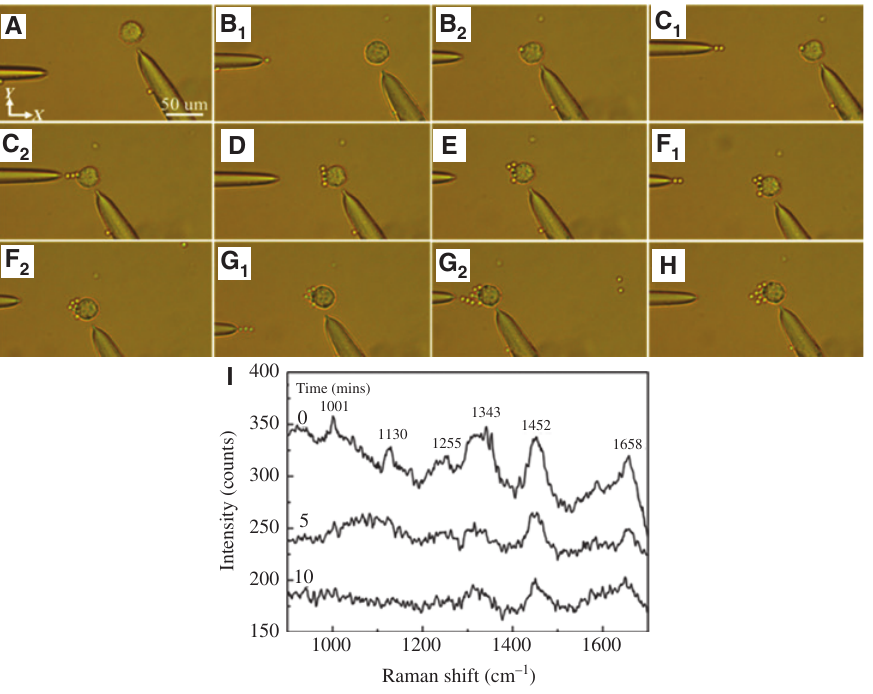
Figure 5: Optical microscope images of delivering 10 MMDs to a single K562 cell and the Raman spectrum of the targeted cell over time. (A) A single K562 cell was trapped by the right TFP and the left TFP was ready for the trapping and delivery of MMDs. (B of the first MMD. (C and C ) The delivery of the second and third MMDs at one time. (D) The fourth MMD was delivered to the targeted cell. 1 2 (E) The fifth MMD was delivered to the targeted cell. (F and F ) The delivery of the sixth and seventh MMDs at one time. (G 1 2 delivery of the eighth, ninth and tenth MMDs at one time. (H) The completed delivery of 10 MMDs. (I) The Raman spectrum of the K562 cell over